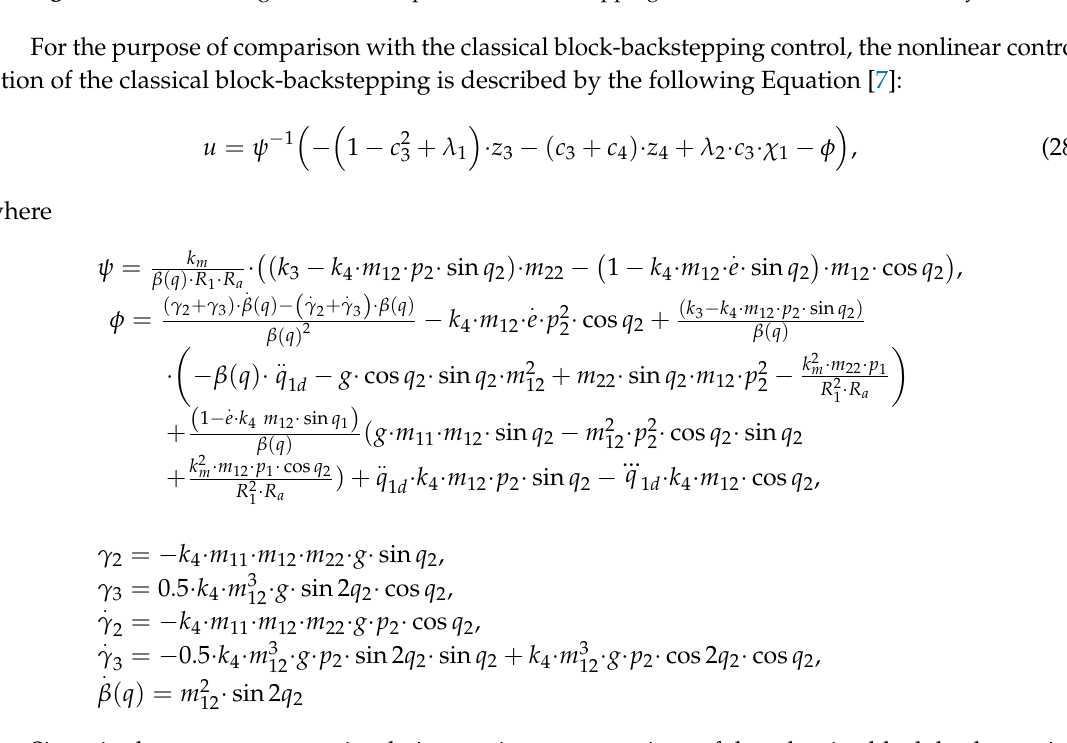
Figure 3. The block diagram of the adaptive block-backstepping-based control for the ball–arc system.